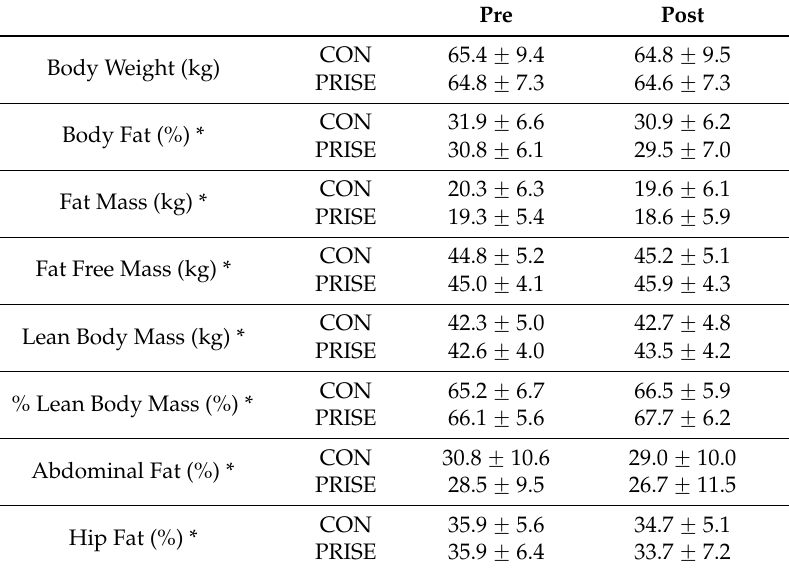
Table 2. Changes in body composition pre ‐ and post ‐ intervention.